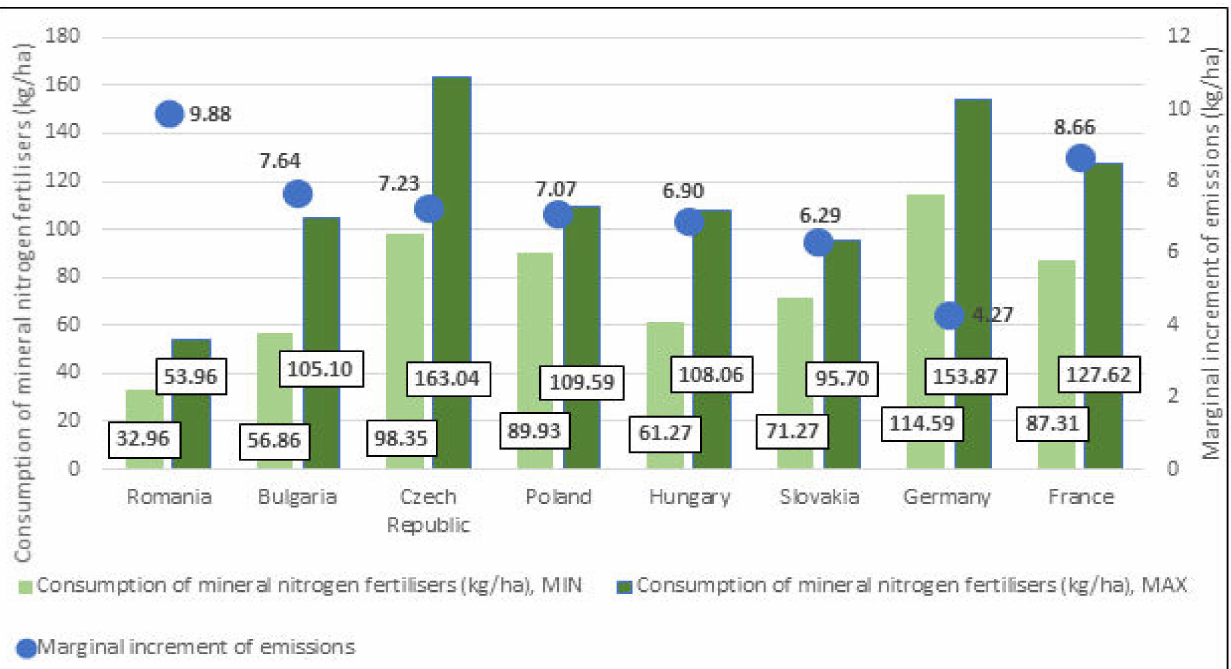
Figure 5. Consumption of mineral nitrogen fertilisers in kg per hectare of arable land (in nitrogen value). Source: own calculation based on